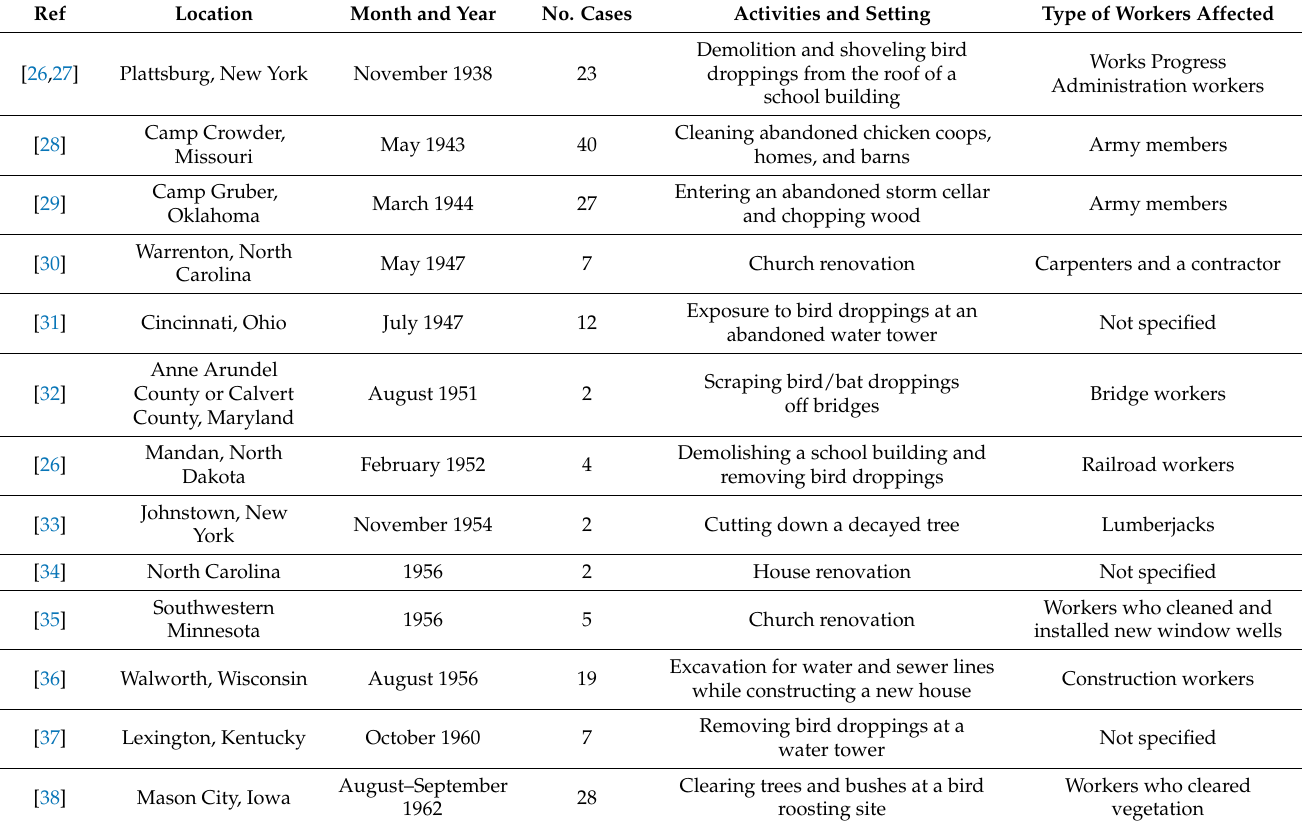
Table 1. Previously reported histoplasmosis outbreaks affecting